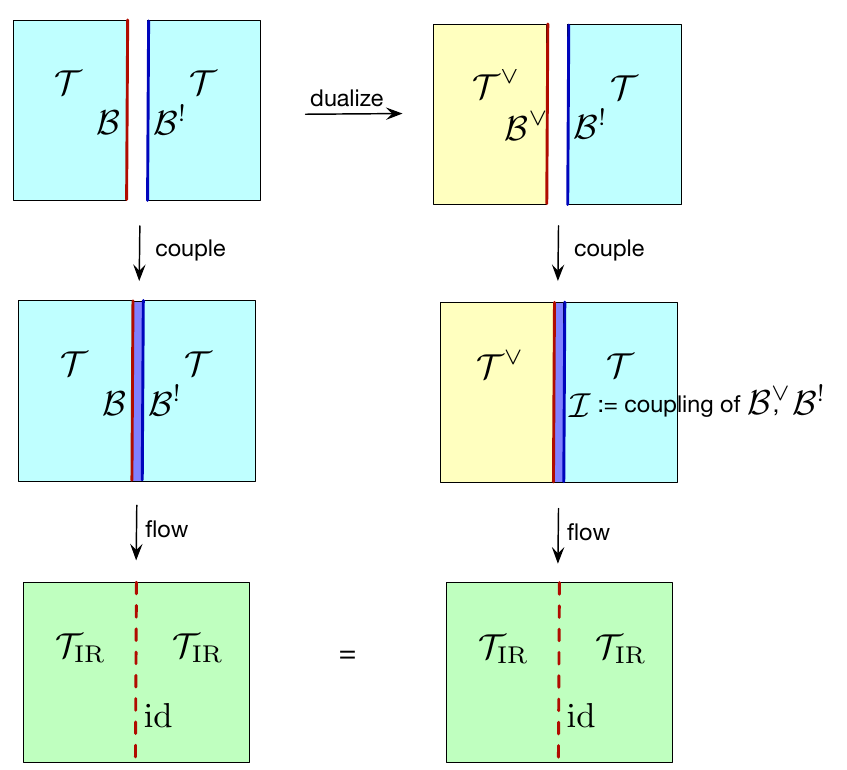
Figure 3 . De(cid:12)ning a duality interface a factorization of the identity interface in interface has the necessary property (that it (cid:13)ows to the identity in the IR) provided that the \diagram commutes"; in particular the coupling on the r.h.s. must involve the appropriate duals of the operators on the l.h.s.